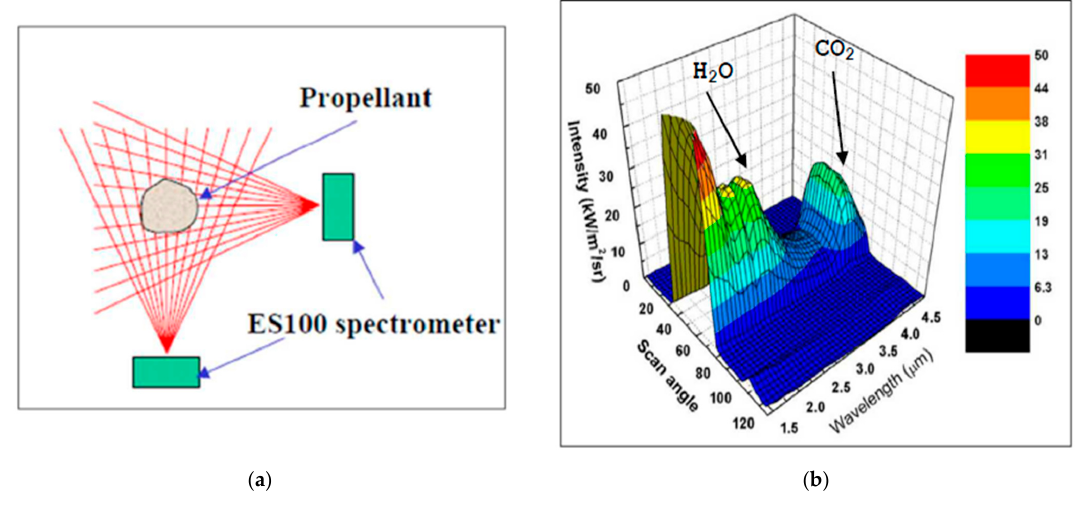
Figure 6. ( a ) Setup for measuring CO 2 and H 2 O gas. ( b ) Intensity spectrum obtained with the Spectraline system. Reprinted with permission from Ref. [26] (2014).